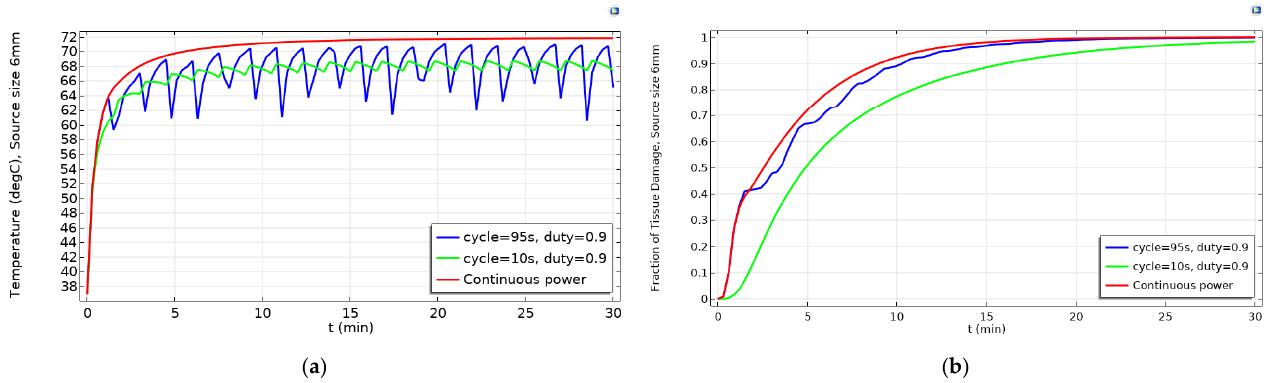
Figure 4. The change in ( a ) the temperature and ( b ) the fraction of tissue damage at the source diameter of 6 mm with pulsed powers during the 30-min simulation.